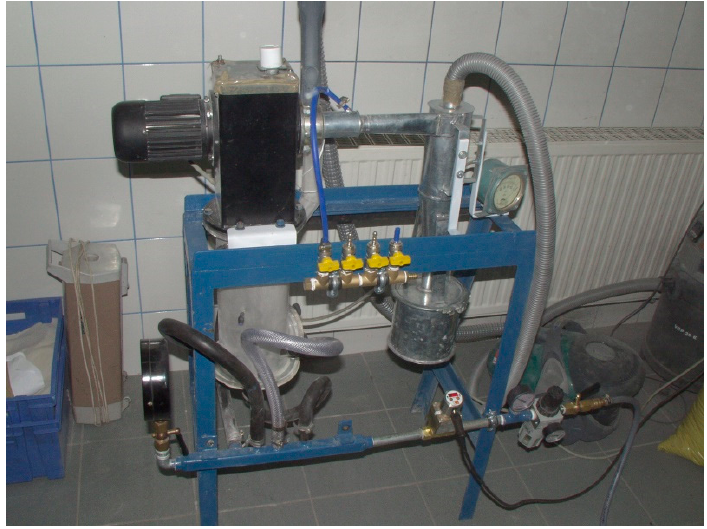
Figure 2. View of the testing stand.